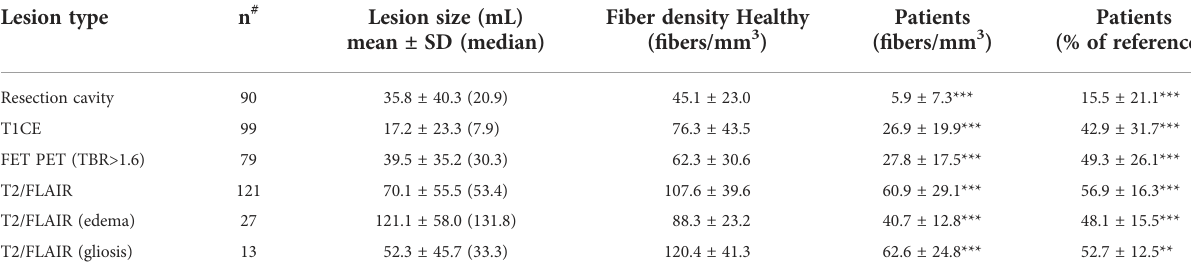
TABLE 2 Volume and fi ber density in lesions of different type.